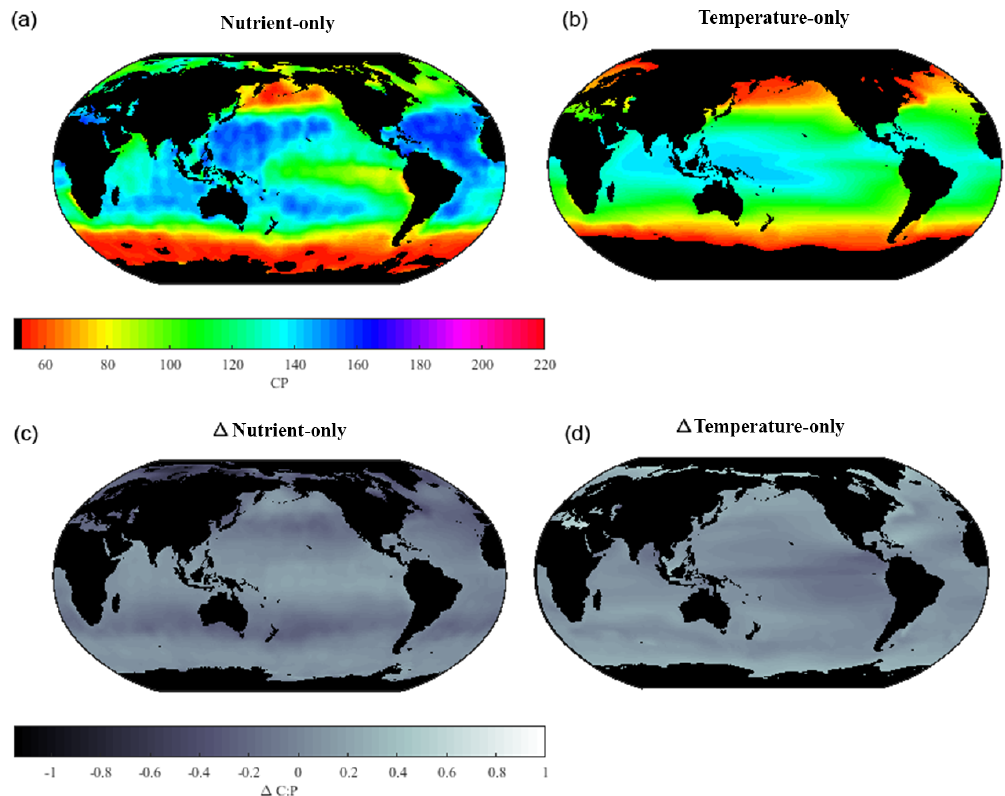
Figure 8. Comparison of C : P between the multi-environmental model and the nutrient-only model and temperature-only model. The upper panels show predicted C : P for the global ocean under the nutrient-only (a) and temperature-only (b) models, and the lower panels show the : P subcell − C : P other normalized difference, i.e., C , between the C : P in the subcellular model (c, d) C : P subcell